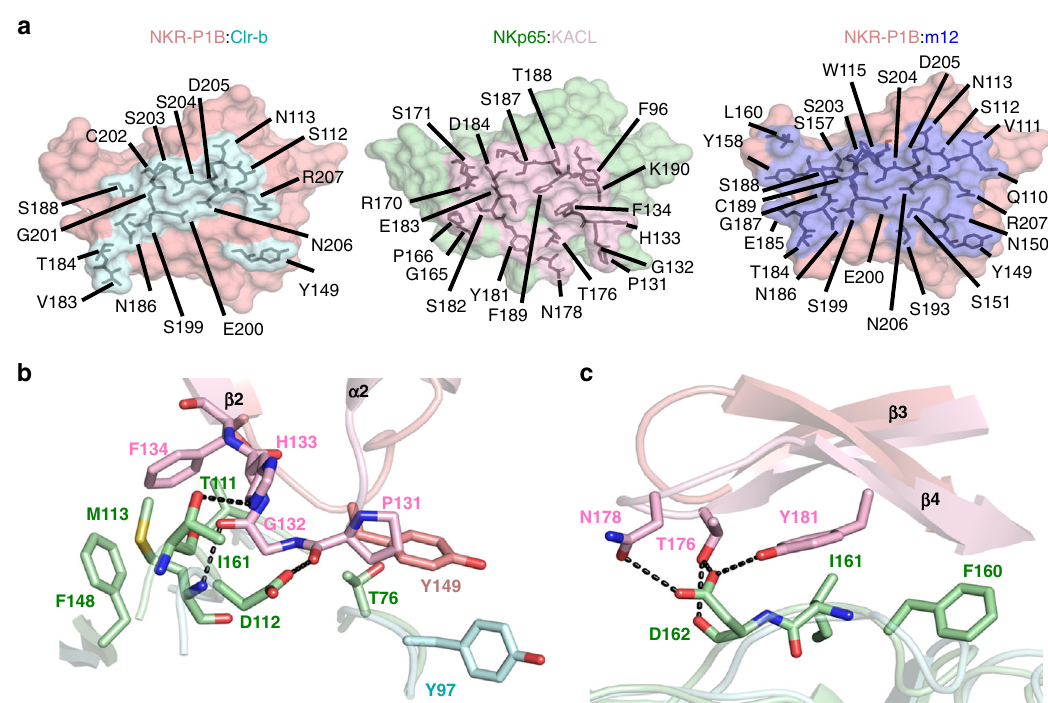
Fig. 4 NKR-P1B:Clr-b interactions. a Surface representation showing the binding footprint made by Clr-b (cyan) and m12 (blue) on NKR-P1B (salmon). For comparison, the surface of NKp65 (green) is shown in the same orientation, with the residues that contact KACL colored pink. b , c Close up views showing contacts that are present in the NKp65:KACL structure (pink and green respectively) but absent in the NKR-P1B:Clr-b interface (salmon and cyan respectively). Residues that form contacts are shown as sticks. H-bonds are represented by black dashed